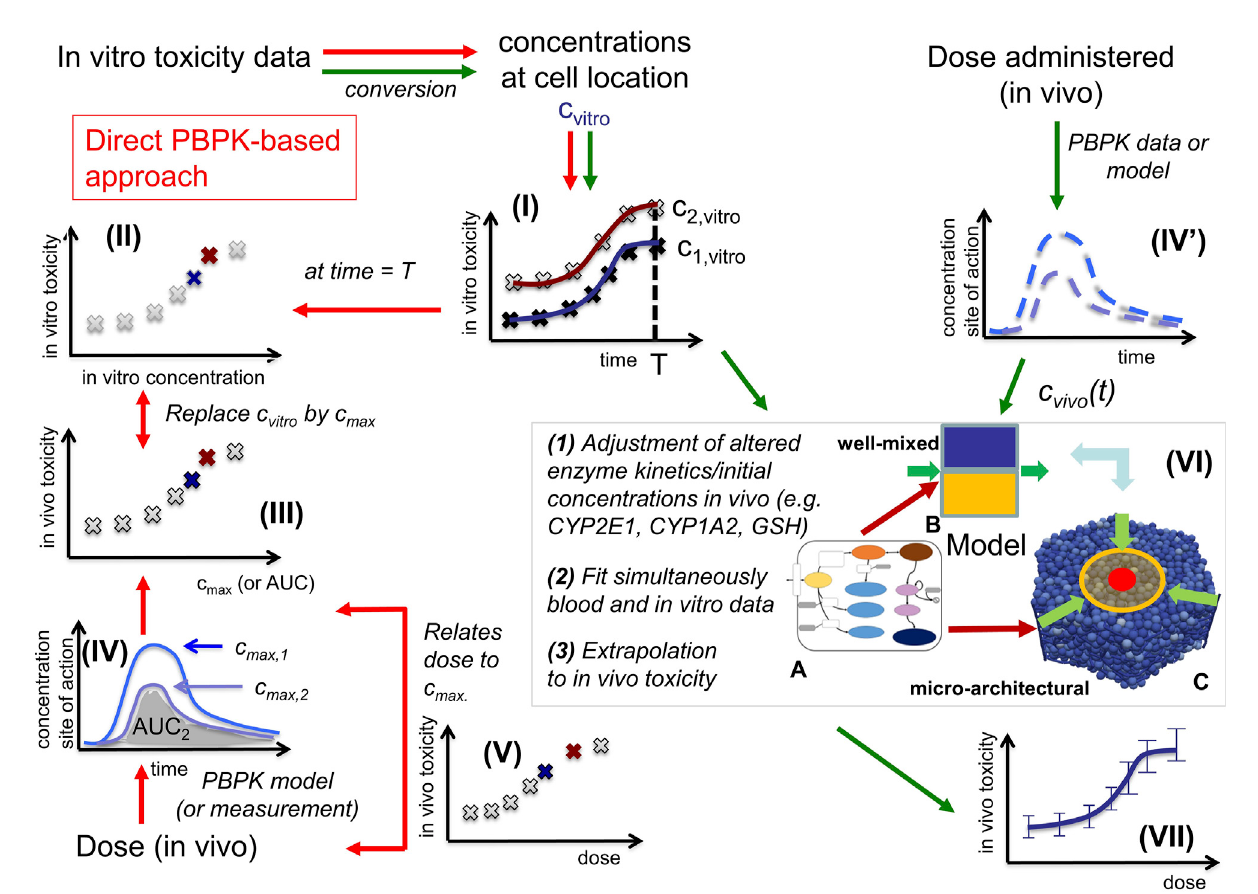
FIGURE 1 In vitro - in vivo extrapolation approaches. In vitro , toxicity is measured by exposing cell populations of interest to certain concentrations C vitro of drug (here: APAP) andmeasuring thefractionofcelldeathwith time (I) .ThetoxicityatacertaintimeT(often:24 h,or3 days)isconsideredas thetime atwhichthe toxicityiscompared (II) .Acommonconsensusforextrapolationto invivo isthatthe invitro concentrationvalueC vitro isidenti fi edbytheC max -value (III) ofthe corresponding pharmacokinetic (PK) curve for the drug in the blood (IV) . The PK curve depends on the administered drug dose, so that by identifying C max and C vitro , the dose value associated with that C max -value can be associated with the toxicity value associated with the corresponding C vitro value (V) . (Alternatively, to the C vitro /C max values, the area under the curve (AUC) is used). The model-based strategy mimics drug toxicity in a model by simulating the processofdrugdetoxi fi cation invitro bythecells,wherebythetoxicitypathwayisexplicitlyrepresentedineachcellandeventuallyintegratedwithaPKmodel (IV) and a compartment model of the organs of interest (VI) . The latter may represent organ microarchitecture, here the liver lobule (VI-C) as repetitive minimaltissueunitorconsiderawell-mixedcompartment (VI-B) ,bothintegratinganintracellularPDmodel (VI-A) .Simulationswith (VI-B,C) directlyyieldthe in vivo toxicity (VII)